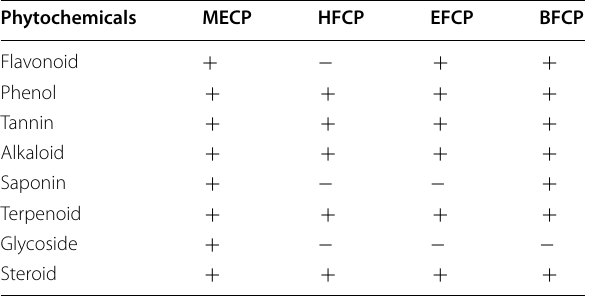
SEM; n 6; *P < 0.05 significant difference ± =